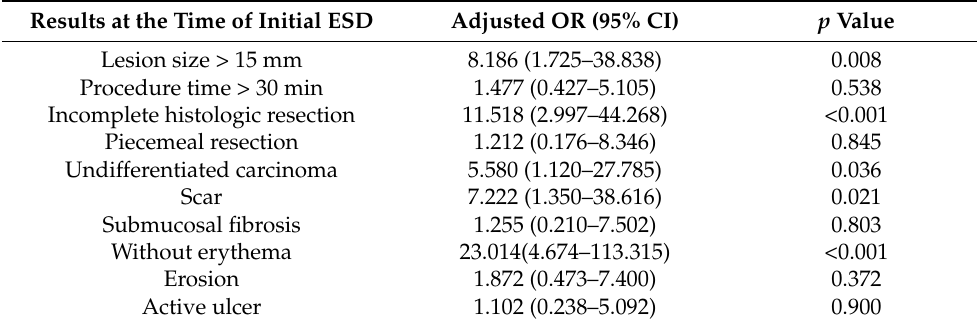
Table 2. Multivariate analysis of factors associated with local